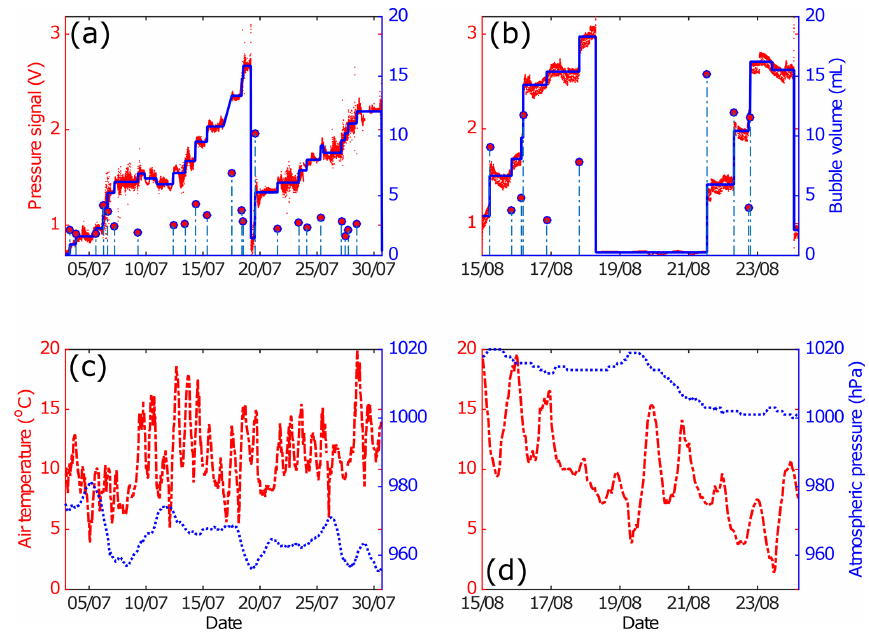
Figure 3. Two measurement periods of an ABC deployed in Mellersta Harrsjön, Stordalen Mire, Abisko, in 2015. (a, b) Sample period when bubbles entering the trap were detected from the denoised pressure signal. Red dots are trap pressure signals, blue lines are the denoised pressure sensor signal, and stem plots (dashed vertical lines with a red circle on top) are bubble events. (c, d) Air temperature and atmospheric pressure from an onshore weather station during the same sample period. Red dashes are air temperature and blue dots are atmospheric pressure.